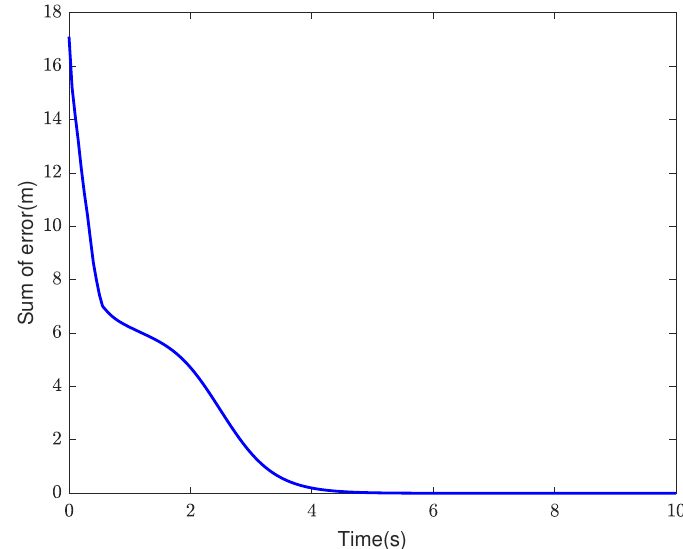
Figure 7. The sum of distance errors of 9